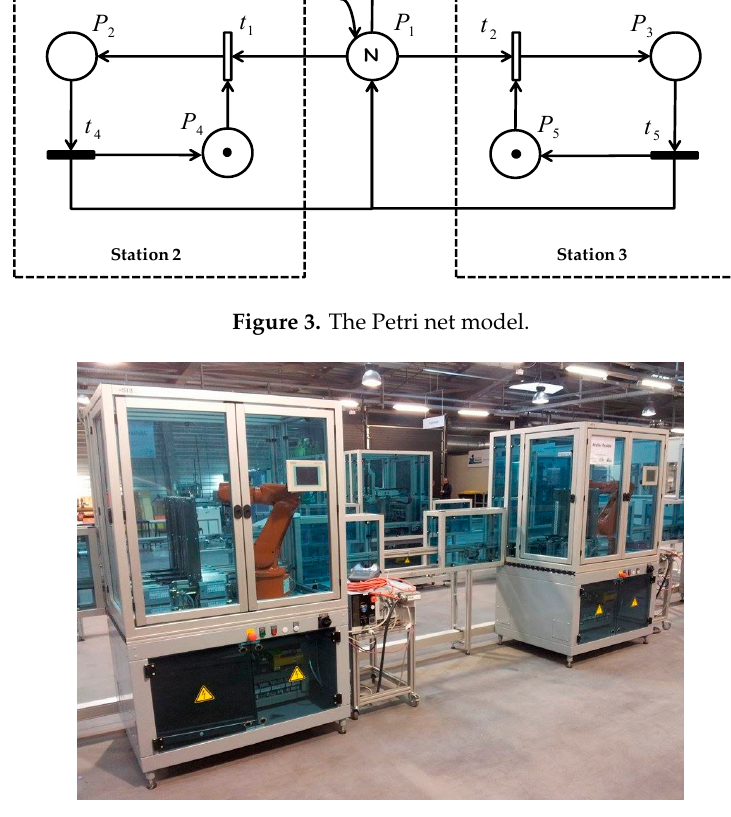
Figure 4. The experimental environment.